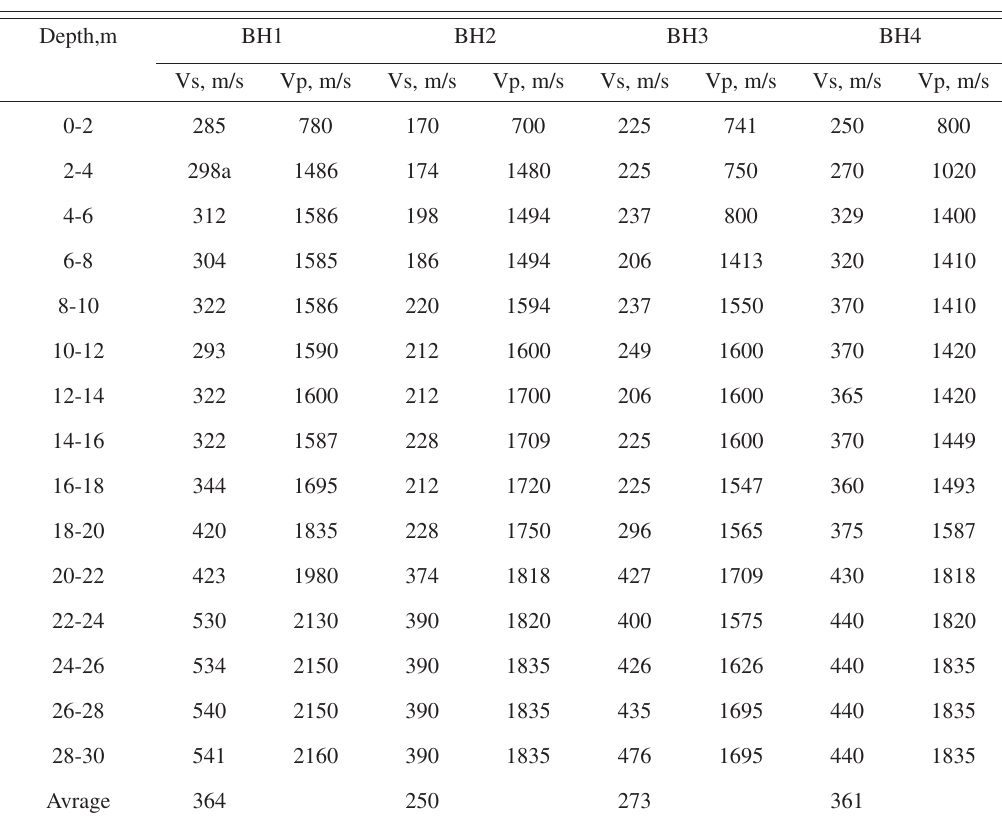
Table III. Interval S-wave and P-wave velocities in